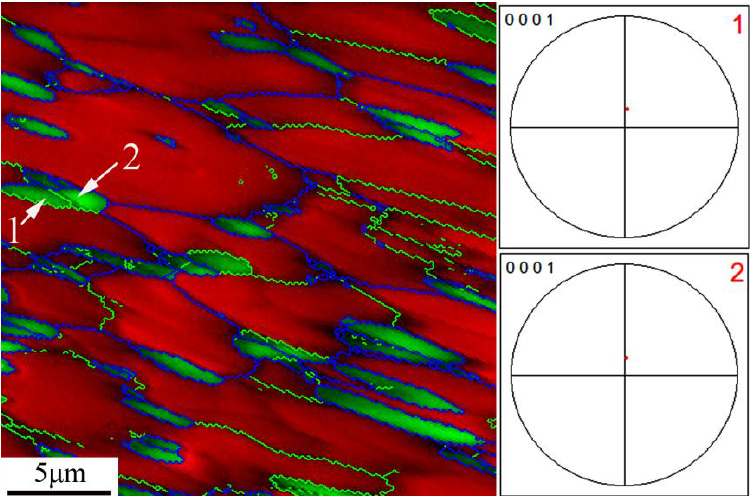
Figure 5. Phase composition and grain boundary map of the alloy deformed at 1028 K with the strain rate of 0.001 s −1 . (The red field = β phase, green field = α phase, blue line = HAGBs (θ ≥ 15°), green line = LAGBs (15° ≥ θ